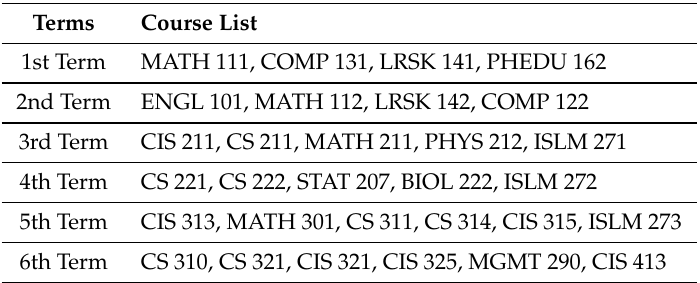
Table 2. Courses taken by term by regular CCSIT students during the academic years 2011/2012, 2012/2013, and